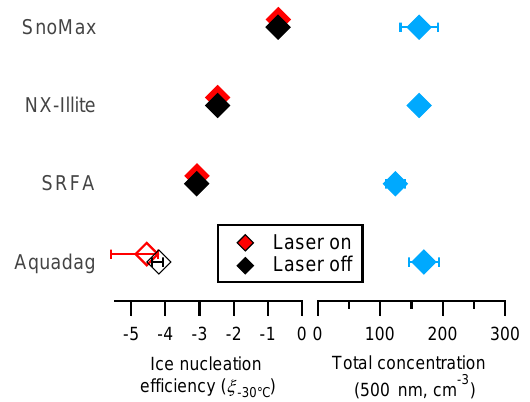
Figure 7. The ice nucleation efficiencies and total concentrations of pure, 500nm size-selected Snomax ® , NX-illite, SRFA, and Aquadag ® . Filled and unfilled symbols are above and below the de- tection limit of the CFDC when corrected for SP2 dilution, respec- tively. The errors bars represent 1 standard deviation of the mean from at least three measurement periods.